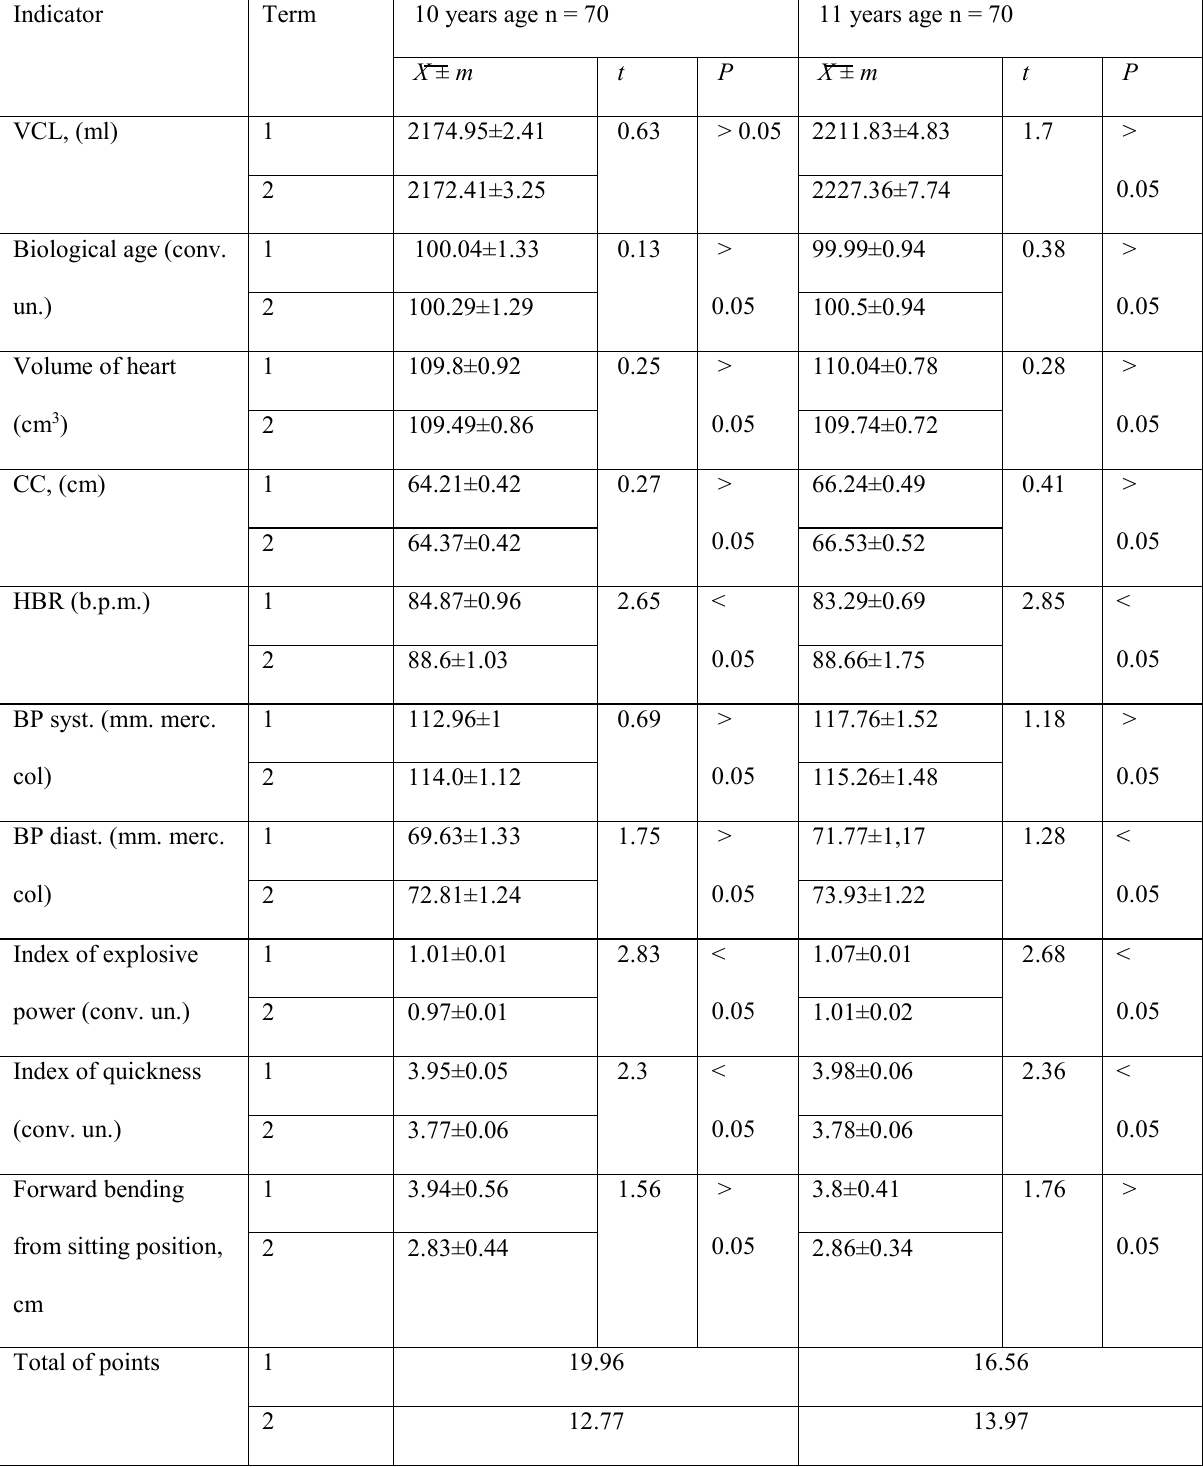
Indicators of physical condition at the beginning of academic year and at the end of first